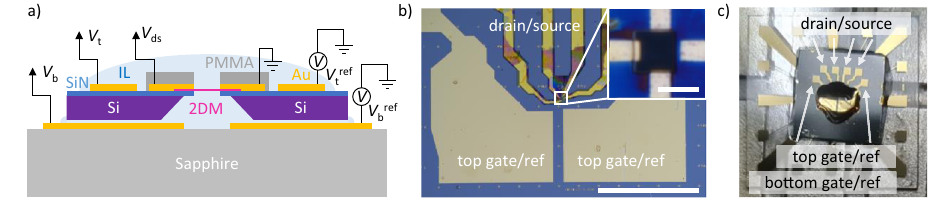
covered with cross-linked PMMA. Scale bar is 1mm. Inset: 100x image of the 2DM deposited onto a square hole (~4 μ m×4 μ m) in SiN. Everything in the inset other thantheareaofthe2DMovertheholeiscoveredbycross-linkedPMMA.Scalebaris 4 μ m. c Photograph of sample #1 before measurement. Note that the top and bottom ionic liquids are not in contact.